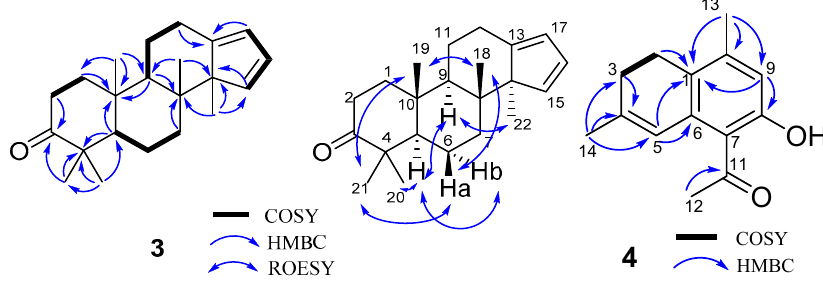
Figure 6. Key 1 H- 1 H COSY and HMBC correlations for 3 and 4.